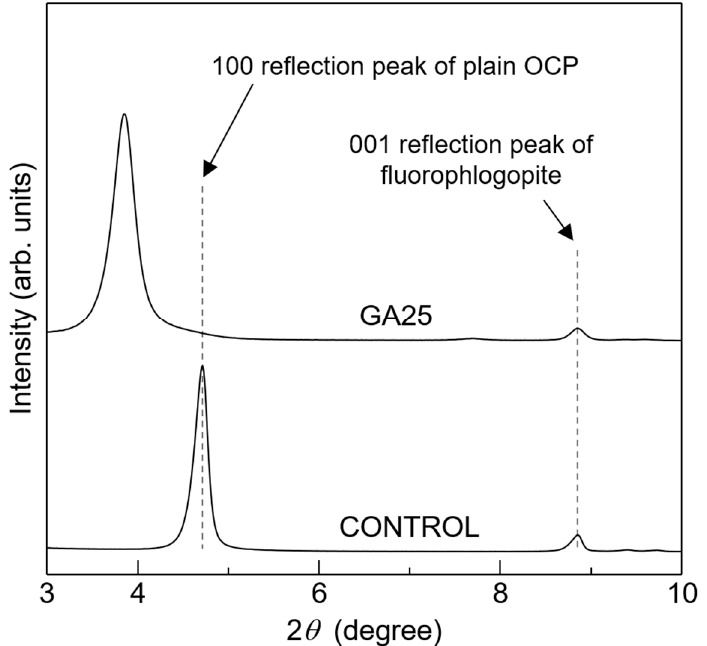
Figure 3. XRD patterns of plain OCP (control) and the OCP sample synthesised using 25 mmol of glutaric acid (GA25) with fluorophlogopite (an angular standard material).